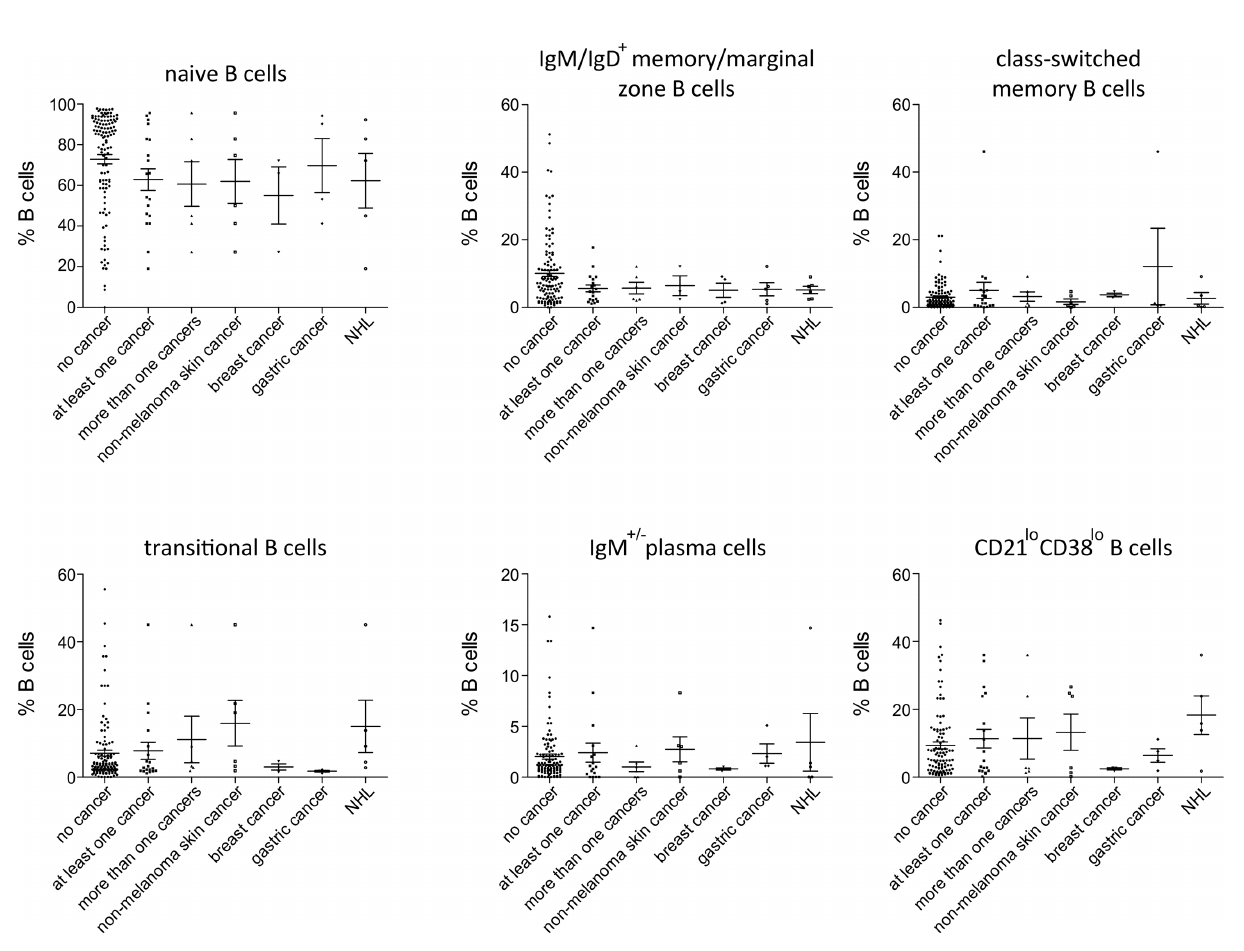
FIGURE 3 | Peripheral B-cell subset in patients with no cancer ( N = 116), patients with at least one cancer ( N = 19), more than one type of cancer ( N = 6), non- melanoma skin cancer ( N = 6), breast cancer ( N = 3), gastric cancer ( N = 4) and non-Hodgkin lymphoma (NHL, N =5). No signi fi cant differences could be detected.